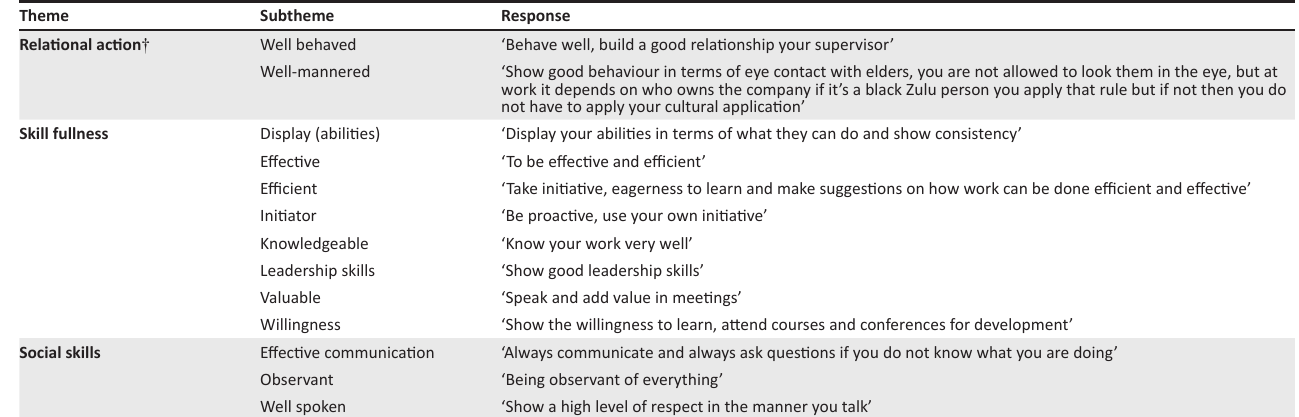
TABLE 2 (Continues...) : Impression management features used with supervisors. Theme Subtheme